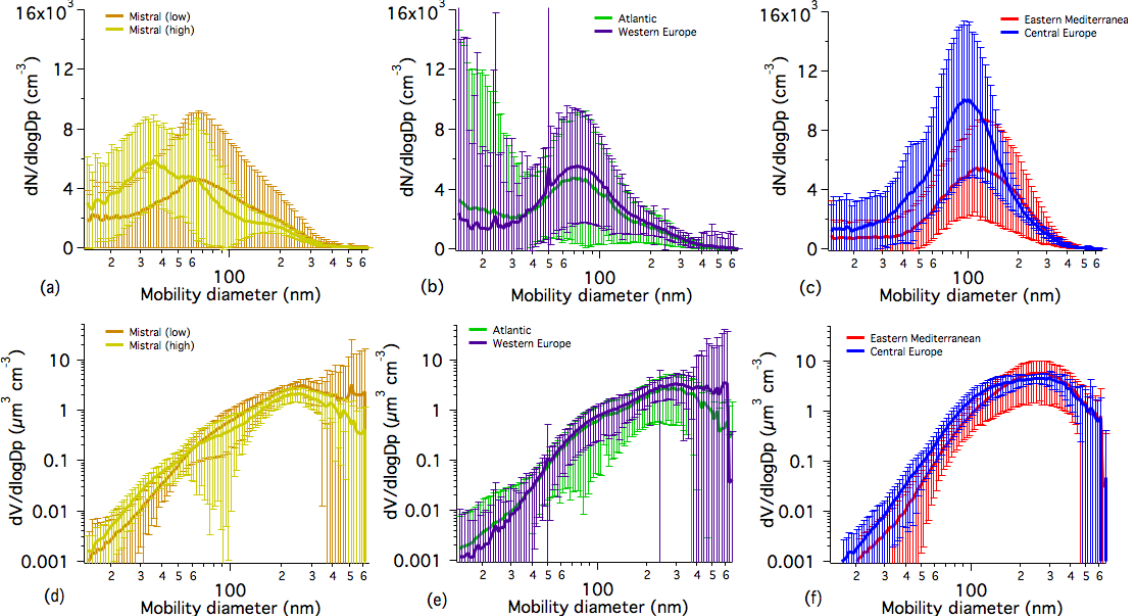
Figure 12. The number size distribution of PM 1 aerosol, coloured by averages for different air-mass origins: (a) mistral (high) and mistral (low); (b) Atlantic and western Europe; (c) eastern Mediterranean and central Europe; and the volume size distribution of PM 1 aerosol, coloured by averages for different air-mass origins: (d) mistral (high) and mistral (low); (e) Atlantic and western Europe; (f) eastern Mediter- ranean and central